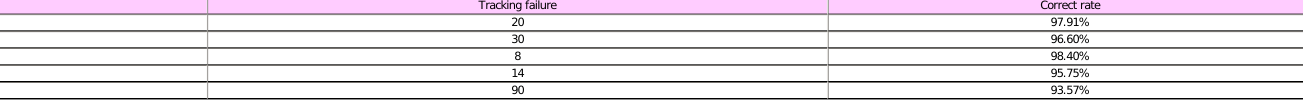
Figure 14 Trajectory of the real and estimated eyes center in a 100-frame sequence.